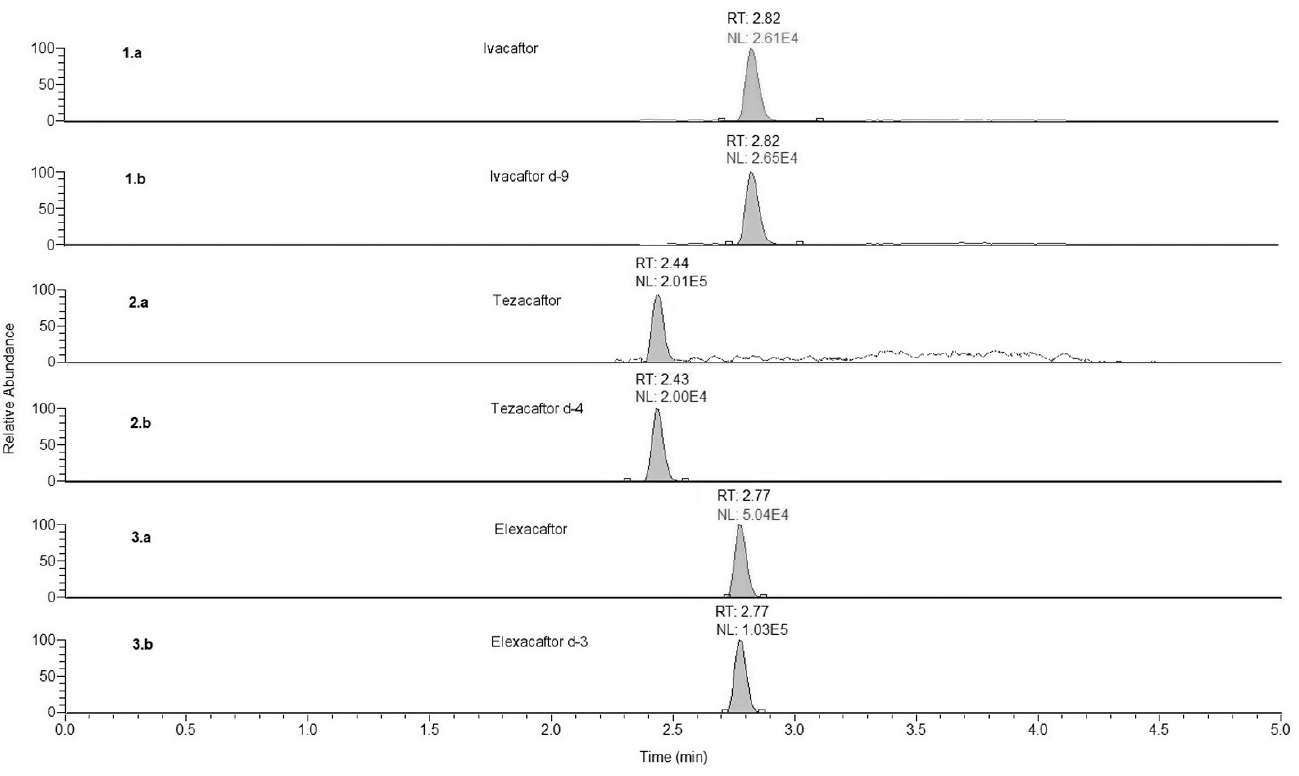
Figure 1. Chromatograms obtained: a calibrator at the LLOQ in plasma (panel 1.a, ivacaftor; panel 2.a, tezacafor, panel 3.a, elexacaftor); deuterated internal standards (panel 1.b, ivacaftor-d9, panel 2.b, tezacafor-d4, panel 3.b, elexacaftor-d3). RT, retention time. NL, normalized